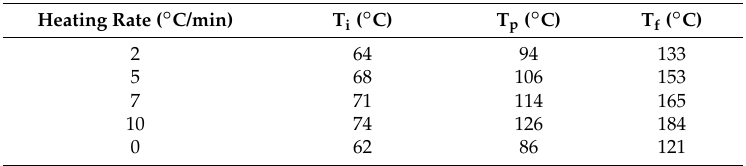
Table 1. Characteristic temperatures of the resin